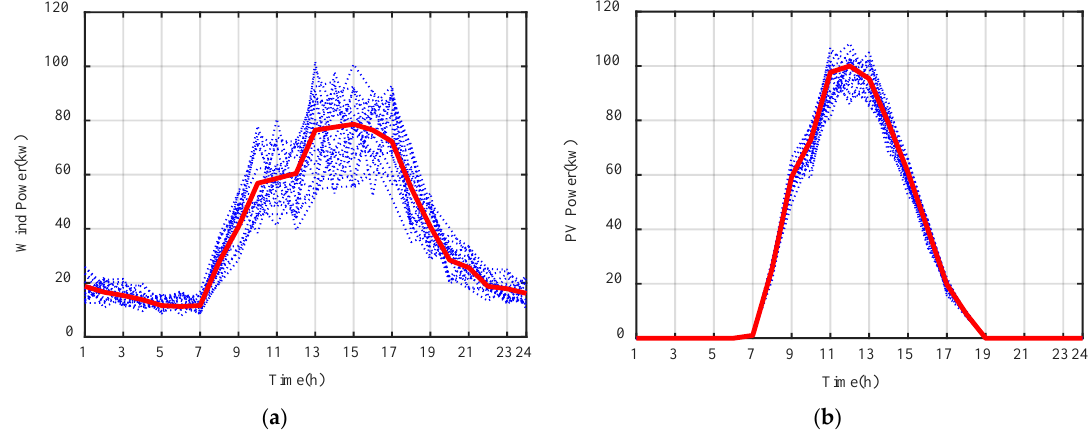
Figure 13. WT ( a ) and PV ( b ) power outputs in 50 scenarios.